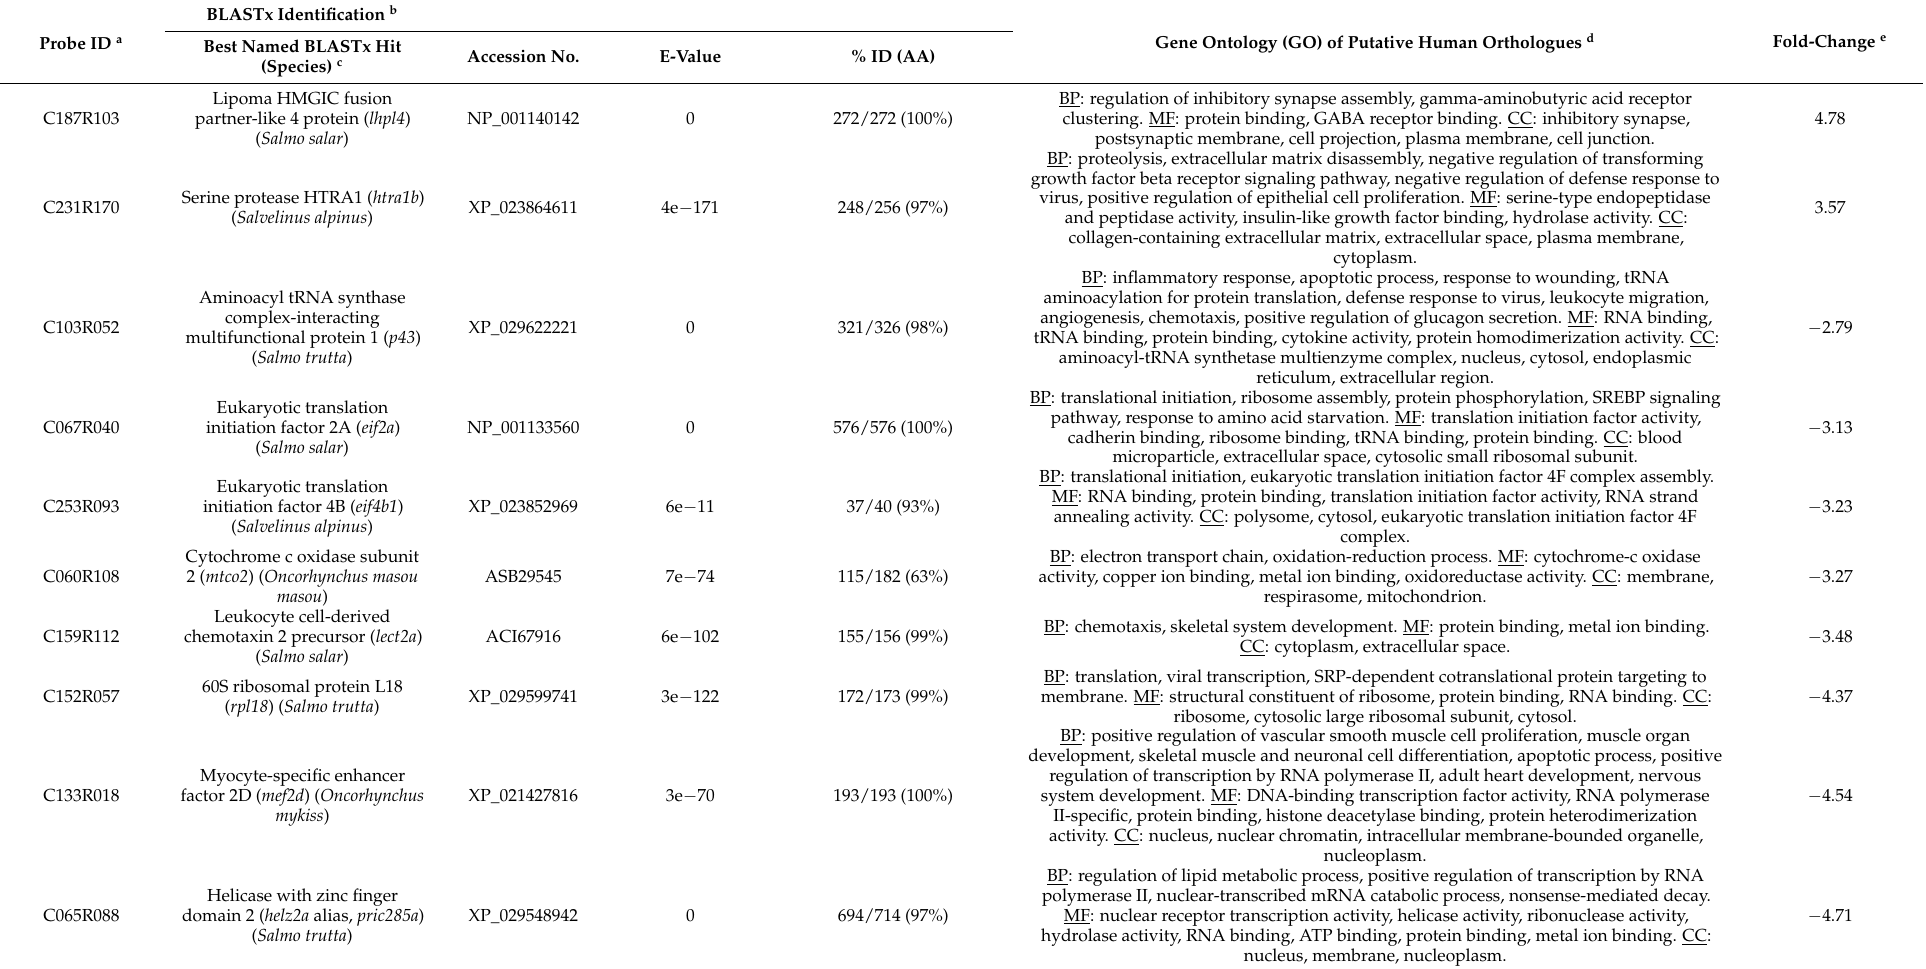
Table 2. Microarray-identified transcripts that were significantly differentially expressed in the liver of salmon fed high ω 6 compared to high ω 3